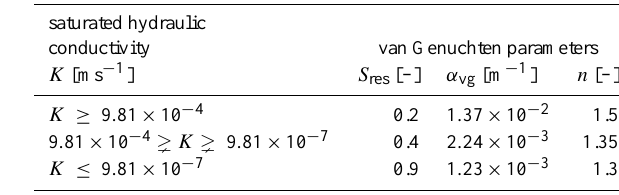
Table 1. Lookup table for van Genuchten parameters in SPRING. S res is residual saturation, α vg is the parameter related to the in- verse of air entry suction and n is the parameter related to pore size